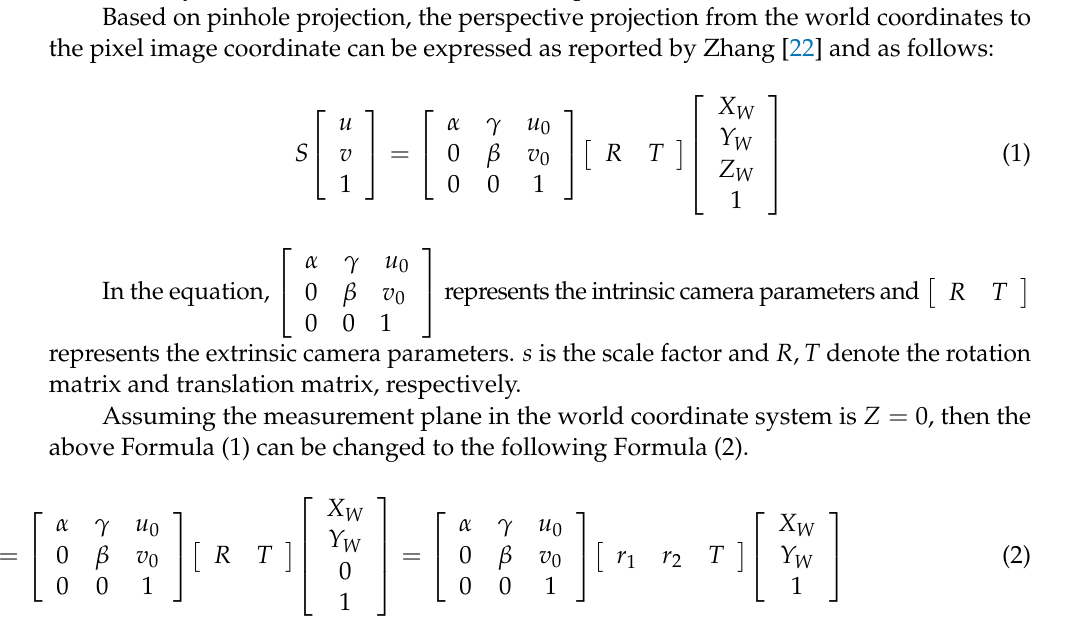
Figure 2. Imaging model of the pinhole camera. 𝑂 − 𝑋 𝑌 𝑍 (cid:3050) (cid:3050) (cid:3050) (cid:3050) is the world coordinate system. The coordinate of point world coordinate system can be expressed as (𝑋 (cid:3050) , 𝑌 (cid:3050) , 𝑍 (cid:3050) ) , and its unit is mm. 𝑂 (cid:3030) − 𝑋 (cid:3030) 𝑌 (cid:3030) 𝑍 (cid:3030) is the camera coordinate system, with the measurement unit mm. 𝑜 − 𝑥𝑦 is the physical image coordinate system, the measurement unit of which is mm. 𝑂 (cid:2869) − 𝑢𝑣 is the pixel im- age coordinate system, and its measurement unit is pixel.